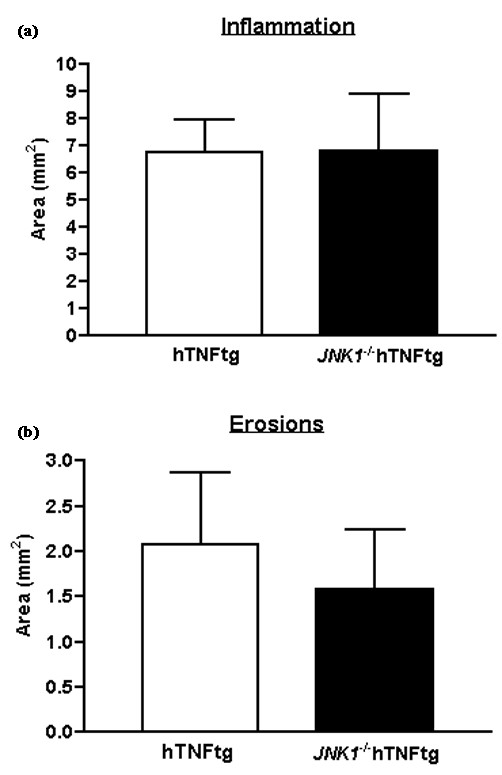
Quantitative analysis of synovial inflammation and joint destruction. There were no differences in the extent of inflammatory tissue between human tumour necrosis factor transgenic (hTNFtg) and intercrossed (JNK1-/-hTNFtg) mice. Mean areas of inflammation (a) and erosions (b) were comparable in these two strains. Vertical bars indicate standard deviation. JNK, c-Jun N-terminal kinase.